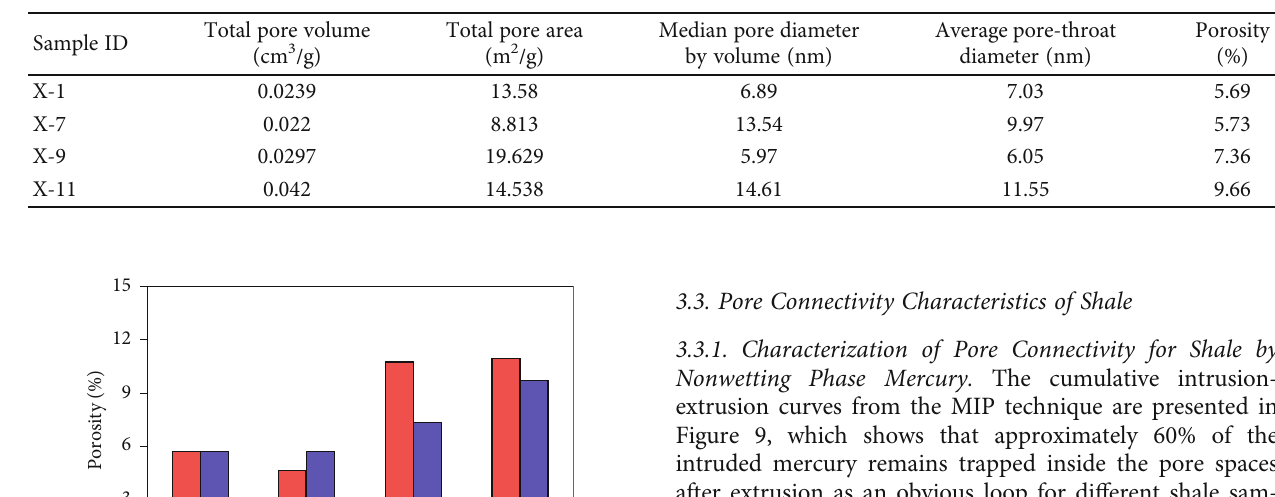
Table 3: Main pore structure parameters obtain from MIP tests for four facies.